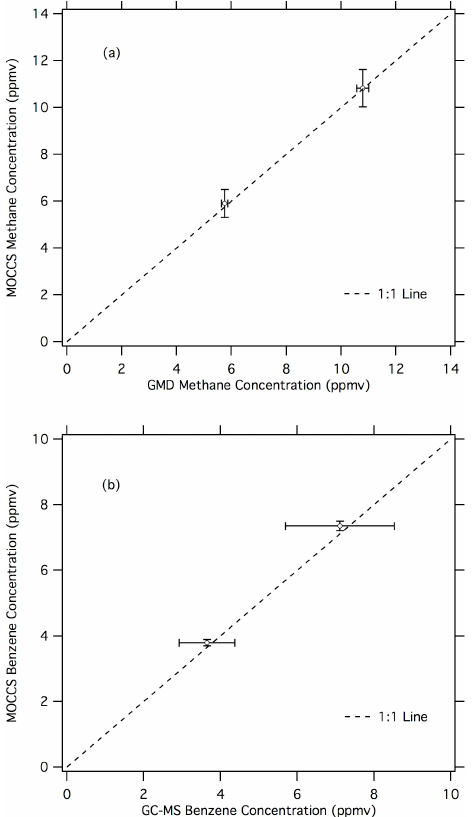
Fig. 4. Results of MOCCS determined methane concentration compared to GMD determined methane concentration of two standards, Fig. 4a. The relative difference between the two measurements is 3%. The results of GC-MS/TOC measurements of two benzene standards generated using MOCCS, Fig. 4b. The relative difference between the two measurements is less than 4%.